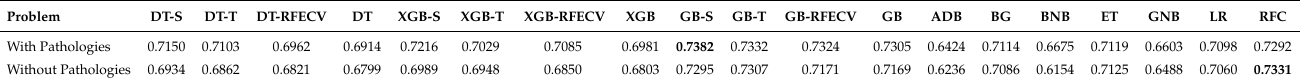
Table 5. Algorithm results by problem (average).